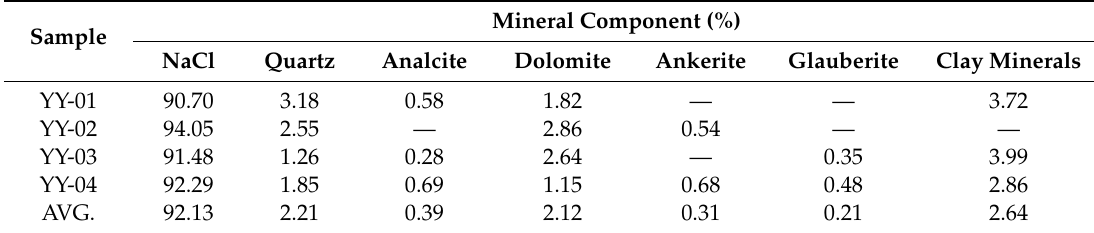
Table 3. Mineral components of rock salt determined by XRD.